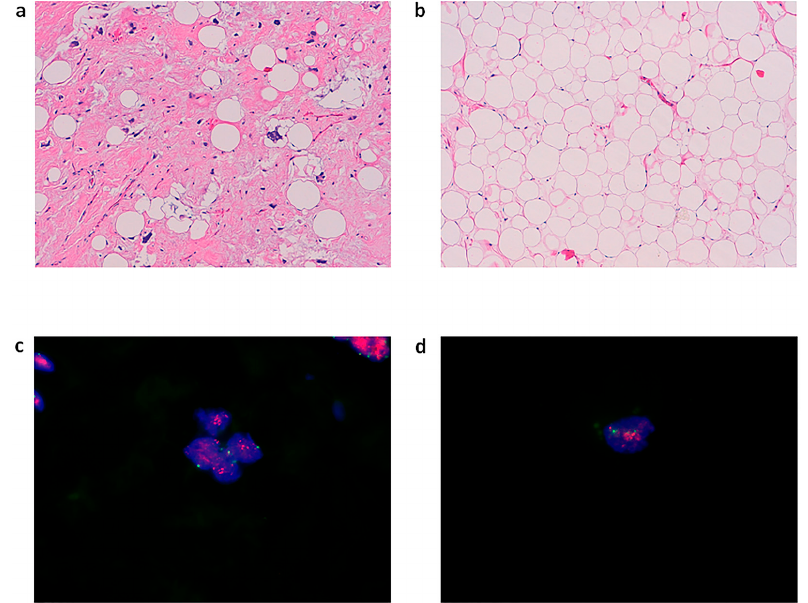
Figure 1. ( a ) HE 10 × staining of the surgical specimen showing DDLPS (light-blue stroma) infiltrating adipose tissue rich in lipoblasts; ( b ) HE 10 × staining of the surgical specimen showing DDLPS (light-blue stroma) infiltrating adipose tissue rich in lipoblasts; ( c ) MDM-2 amplification analysis of patient specimen performed by in situ hybridization at 100 × magnification (Vysis MDM2/CEP12 dual color FISH probe kit); ( d ) MDM-2 amplification analysis of established primary culture performed by in situ hybridization at 100 × magnification (Vysis MDM2/CEP12 dual color FISH probe